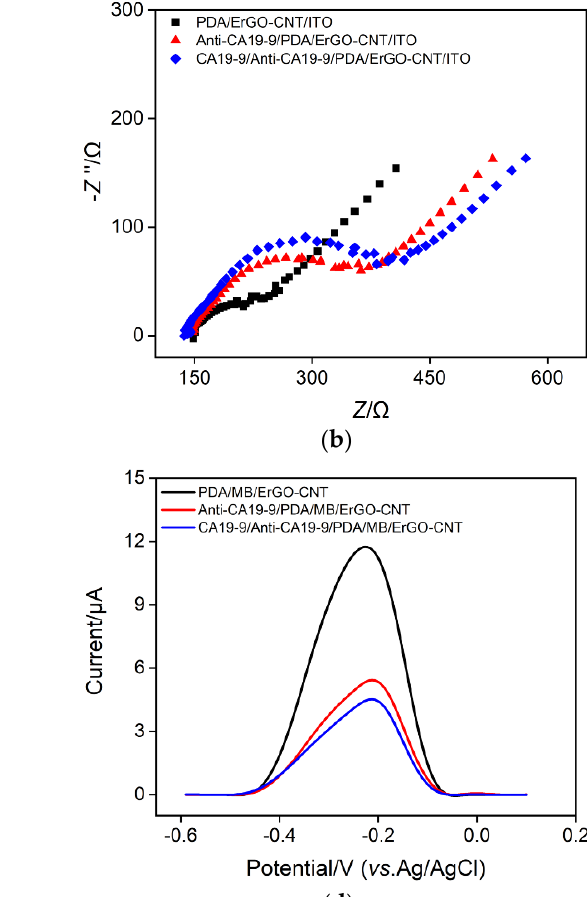
( b ) Figure 6. Successive CV curves of the ( a ) MB/ErGO-CNT/ITO and ( b ) PDA/MB/ErGO-CNT/ITO electrodes in 0.01 M PBS (pH = 7.4). 2.5. Fabrication of Immunosensor The feasibility of the immunosensor construction was verified by the electrochemical method. Figure 7a is the CV curves of each electrode in 0.1 M KCl solution containing 2.5 mM Fe(CN) 63 – /4 – . As shown, Fe(CN) 63 – /4 – displays a pair of reversible redox peaks at the